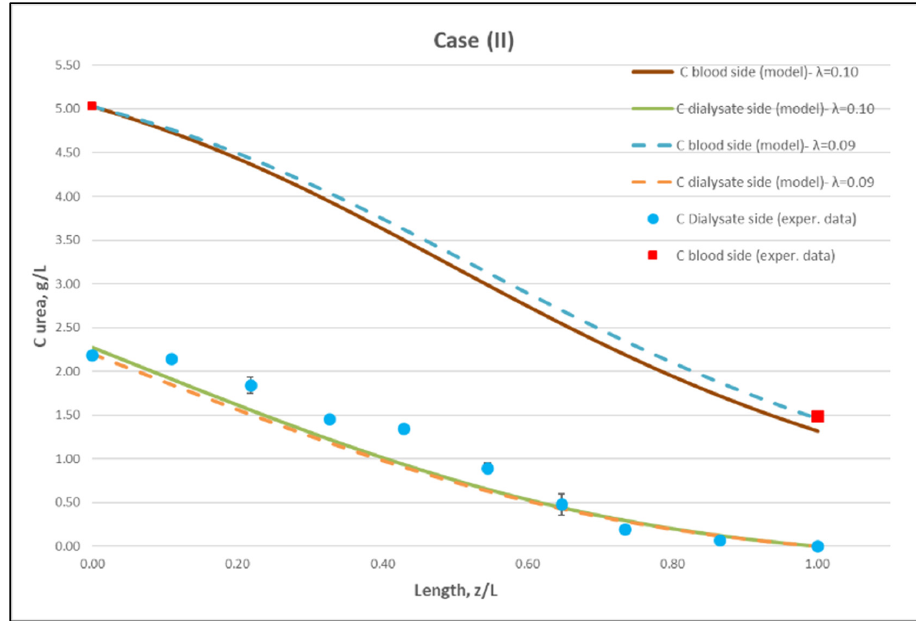
Figure 10. Comparison of measured local urea concentration C D in the dialysate-side, with model predictions, at flow rates Q Blood = 250 mL/min, Q Dialysate = 400 mL/min (Case II). The predicted blood-side urea concentration C B pro fi le is also presented. The points ( ● and ■ ) designate measured values of urea concentration.